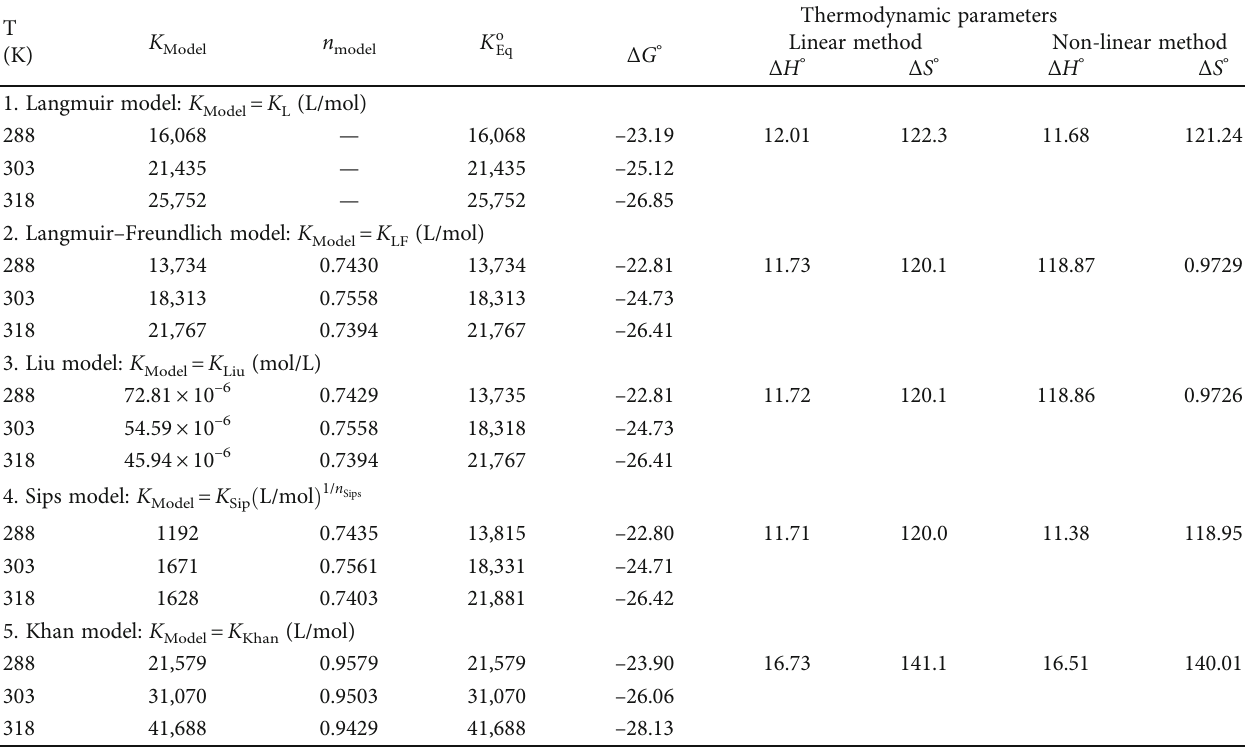
Table 10: The thermodynamic parameters of the adsorption process of methylene green dye using commercial activated carbon calculated based on various adsorption equilibrium constants of the isotherm models [24].